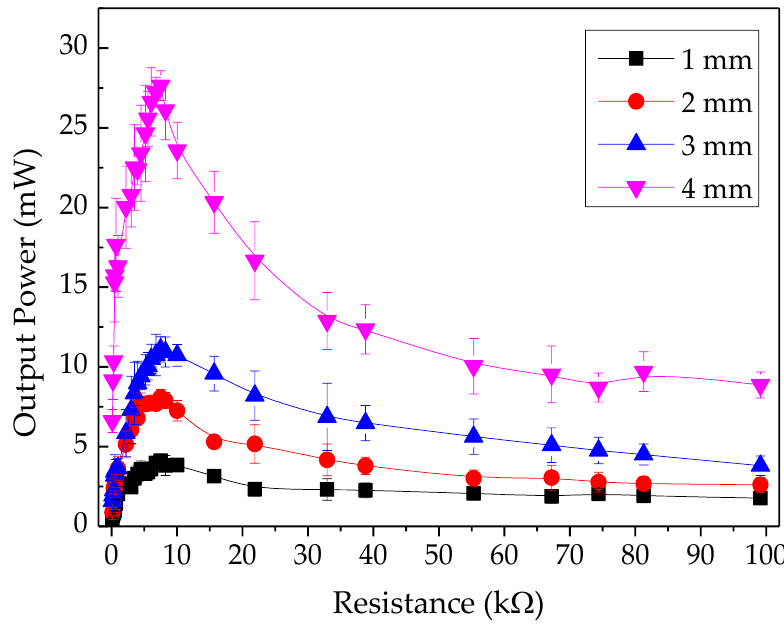
Figure 6. Output power at various gap widths from 1 mm to 5 mm.